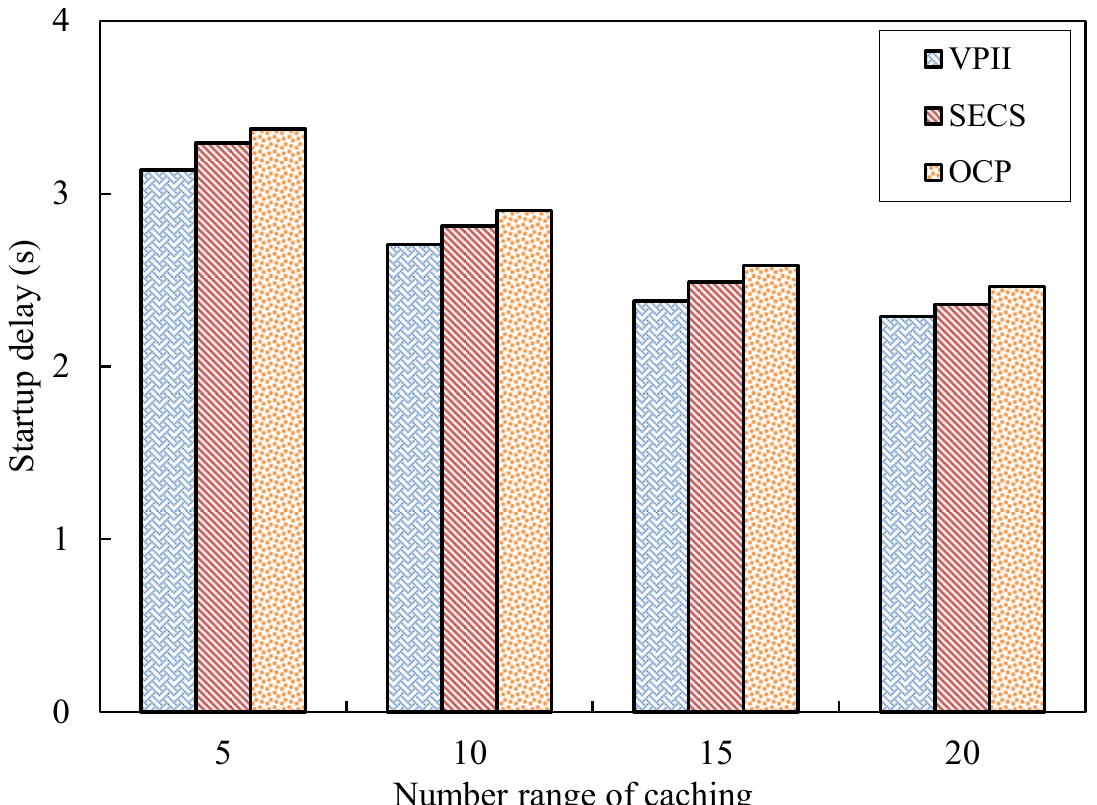
Figure 4. Startup delay against number of cached